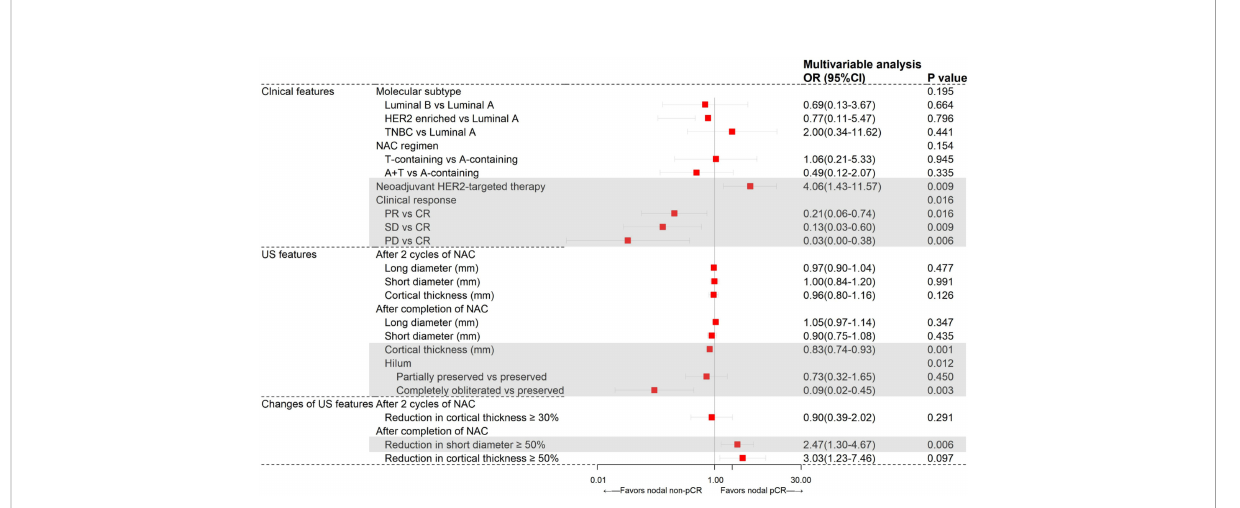
FIGURE 1 Results from multivariate logistic regression analysis of different variables predicting axillary pCR in the training set